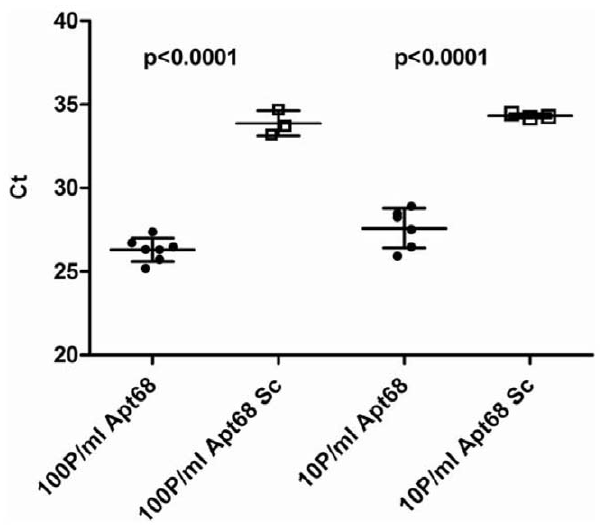
Figure 6. Pull down assay with T.cruzi trypomastigotes from spiked plasma samples. Streptavidin beads, loaded with Apt68 or scrambled aptamer (Apt68 Sc) prepared in SELEX buffer were incubated with a suspension of T. cruzi trypomastigotes, prepared in human plasma, at a concentration of 100 parasites/ml or 10 parasites/ml. The parasite-bead aggregates were then concentrated using a magnet and washed with SELEX buffer. DNA was extracted using the Direct Lysis Buffer (Sigma, Mo.) and aliquots used for real time PCR. The data plotted is a representative of 3 independent experiments. Mean Ct values are plotted on the y-axis with error bars representing the standard deviation of 7 replicates. There was a significant difference (p , 0.001) between the amount of parasite DNA amplified from the samples, when Apt68 coated beads were used, compared to the scrambled aptamer coated beads, low Ct values indicating higher DNA concentration. This trend is observed at both concentrations of the spiked parasites, 100 parasites/ml and 10 parasites/ml. Negative controls, where nuclease free water was used for amplification, showed Ct .